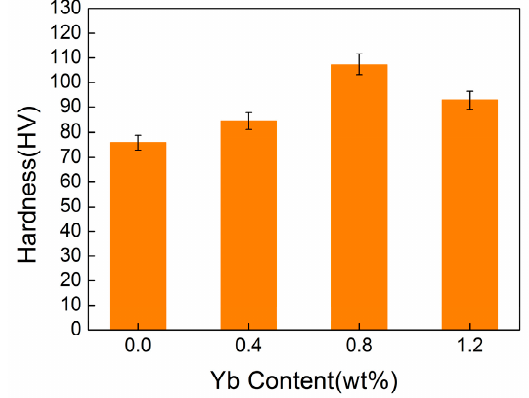
Figure 8 . Hardness of ADC12 alloys with different Yb additions. Figure 8. Hardness of ADC12 alloys with different Yb